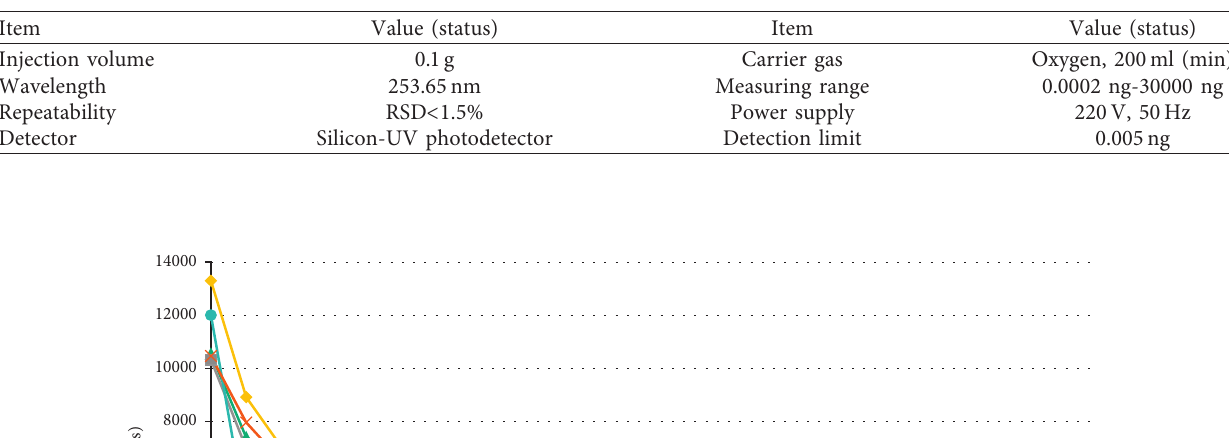
Table 3: Instrumental parameters of the DMA-80 mercury analyzer.